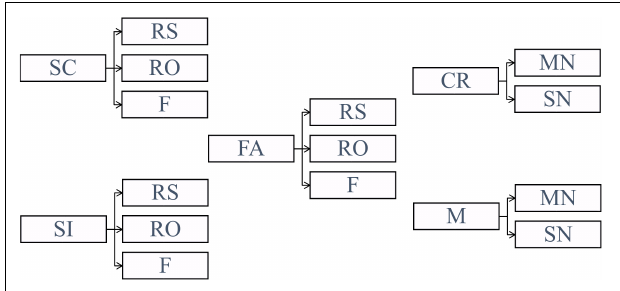
FIGURE 3 | Categorization of the trials based on the subjects’ source judgments (SC, source correct; SI, source incorrect; CR, correct rejection; M, miss; FA, false alarm) and subjective ratings (RS, remember source; RO, remember other; F, familiar; MN, maybe new; SN, sure new).